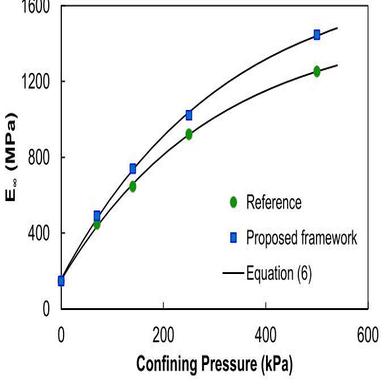
Dependence of the parameter E∞ on confining pressure (Mix A).